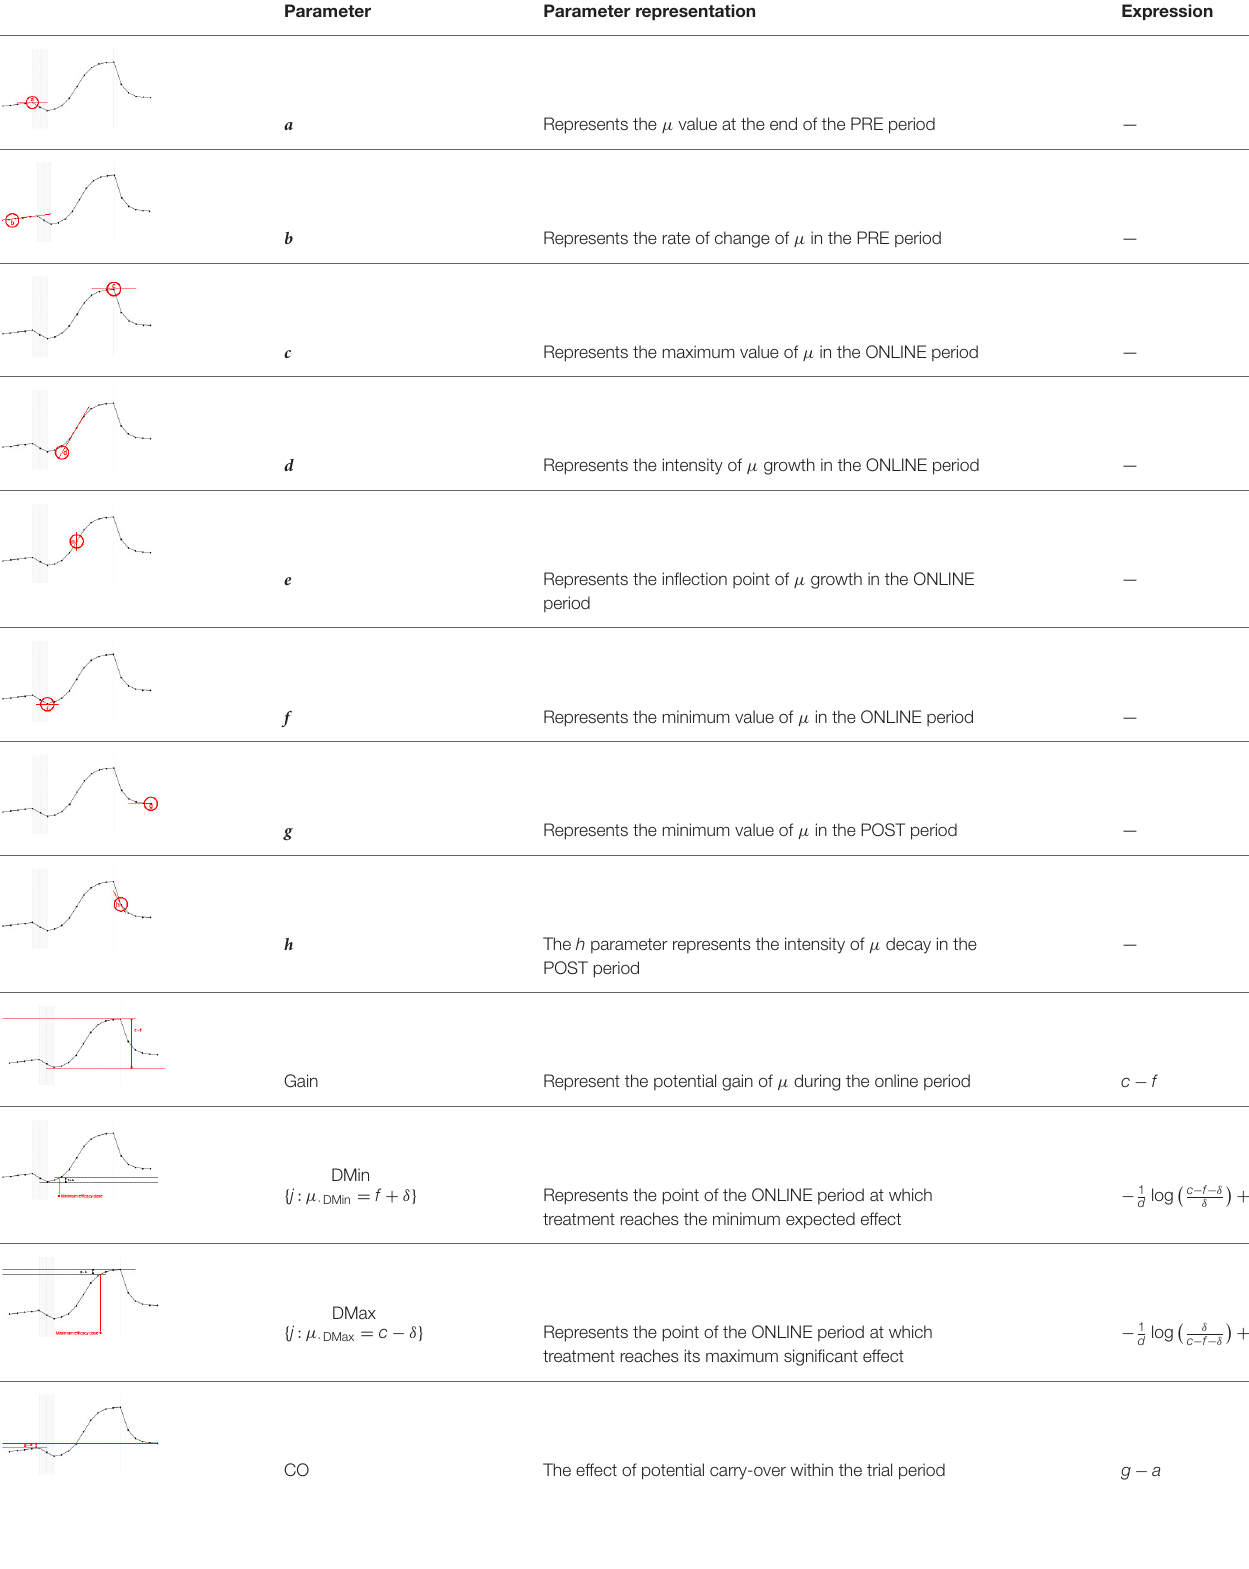
TABLE 1 | Model parameters